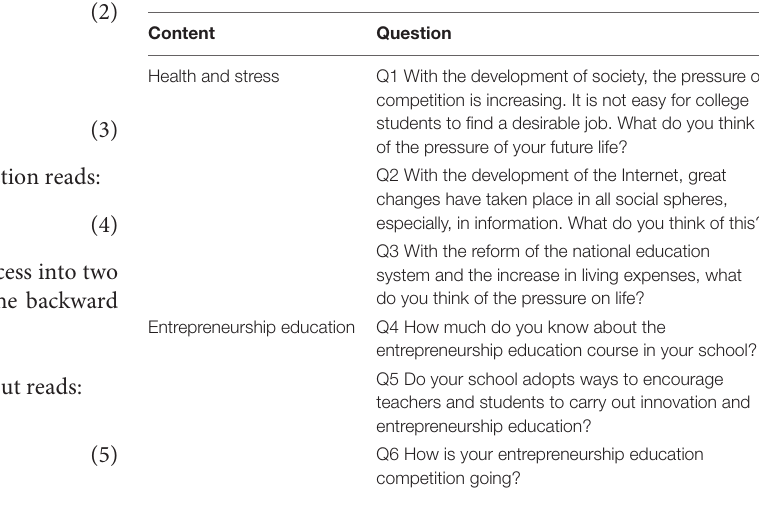
TABLE 1 | Key questions of the